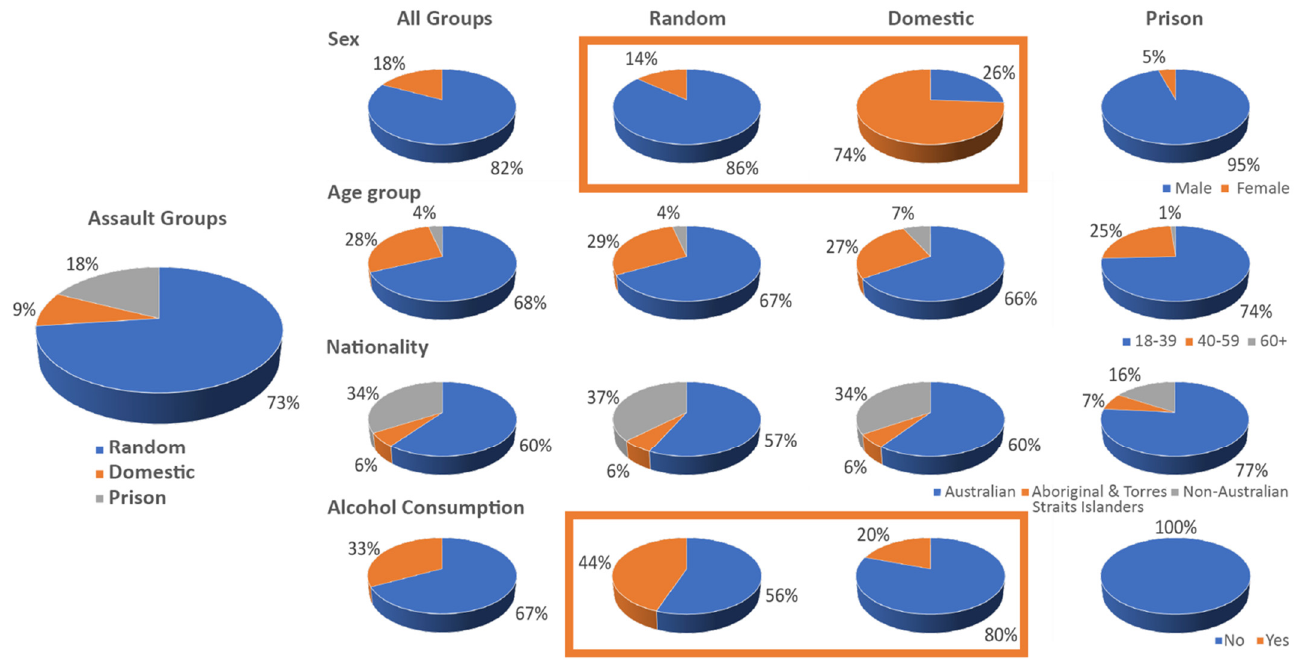
Figure 6. Who was a victim of assault-related TBI in Melbourne, Australia, between 30 July 2018 and 30 October 2021? Left, overall proportion per assault group. Right, breakdown of assault-related TBI by sex, age group, nationality, and alcohol consumption (rows) and assault group (columns). Highlighted in orange squares are noticeably contrasting differences in the proportion of cases between RV and DV assault in terms of sex and alcohol consumption. percentages in nationality and alcohol consumption exclude ‘Unknown’ cases (see Supplementary Table S1).